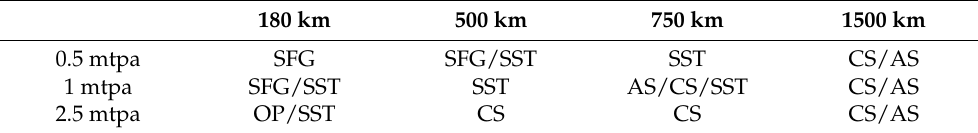
Table 17. Transport methods with the lowest costs for various distances and